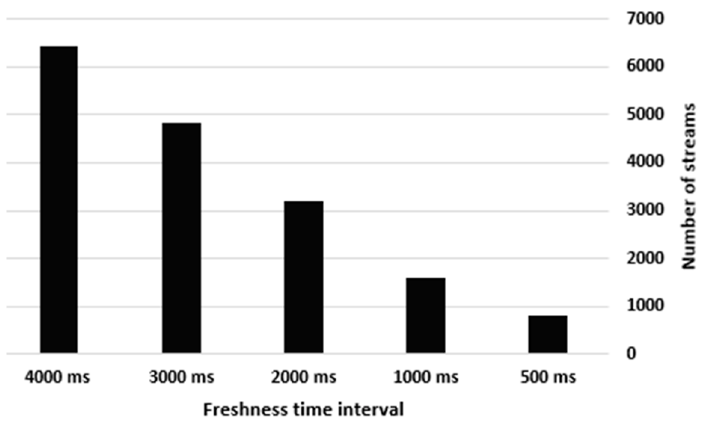
Figure 7. The number of fresh streams with respect to the different freshness time intervals. Table 3. Tracking PPS parameters per second at a sample size of 80 for D1.